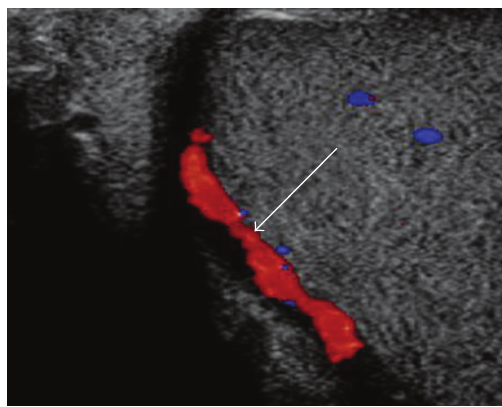
Figure 6: Ultrasonogram of a testis using color pulsed-wave Dop- pler ultrasonography showing blood flow within the marginal ar- tery